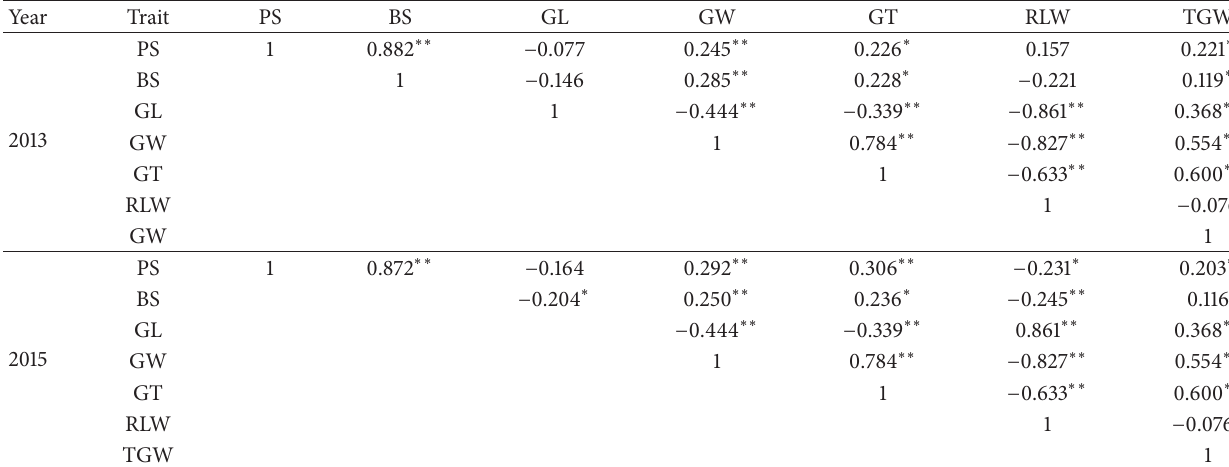
Table 2: Analysis of the correlation coefficients for BTS and grain